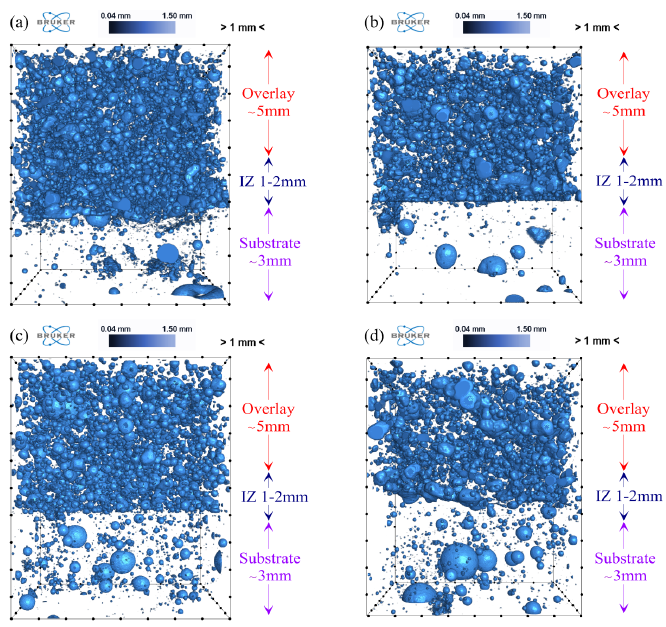
Figure 5. The 3D models of microporosity obtained within the IZ between the overlay made of cement mortar and the existing concrete obtained by the micro ‐ CT method at different moments of overlay hardening for Samples ( a ) T1; ( b ) T2; ( c ) T3; and ( d ) T4. Microporosity φ and the number of pores n within the IZ between the overlay and the existing concrete substrate, obtained using the micro ‐ CT method, are formed as a function along the height of the sample (Figures 6 and 7). The results at four different moments of testing time are set together, and it can be seen that the changes are visible. However, the changes are only visible in the overlay and IZ between the layers, and not for the existing concrete substrate.